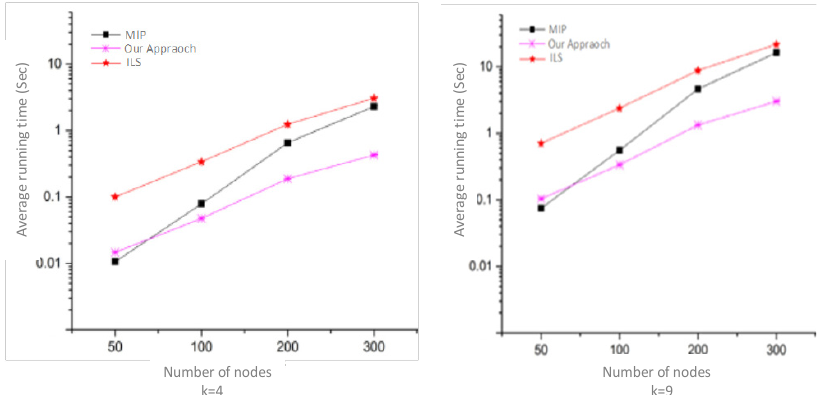
Fig. 8. Average running time for k=4 and k=